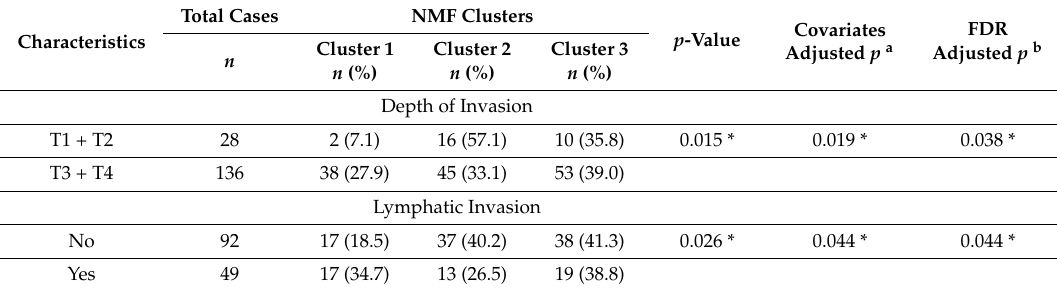
Table 1. Correlations between clinic pathological features and non-negative matrix factorization (NMF) clusters (quantile categorization) for colorectal cancer